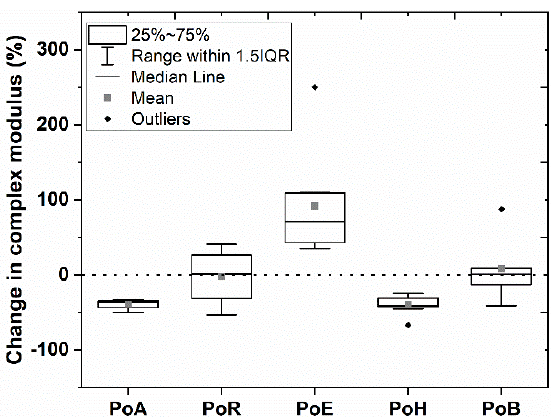
(cid:16) degraded – fresh (cid:17) × 100 of mud samples from × 100(cid:4673) of mud samples from fresh (cid:3033)(cid:3045)(cid:3032)(cid:3046)(cid:3035)